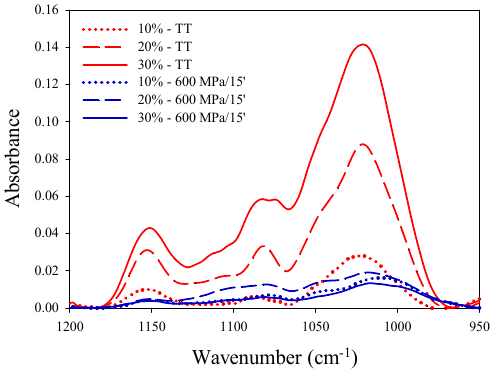
Figure 1. FT-IR spectra of potato starch suspensions at different starch concentration (10%–30% w/w) treated by high pressure (600 MPa for 15 min at 25 °C) and thermal treatments.